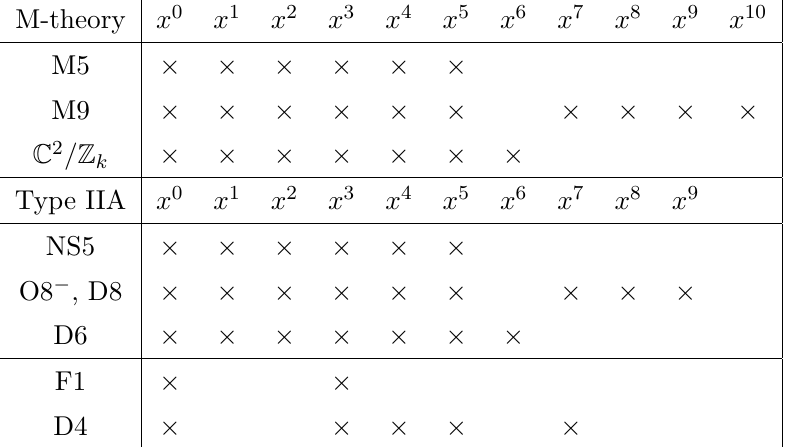
Table 1 . Upper part: occupation of space-time directions by M5, M9, and A k (cid:0) 1 singularity in M-theory. Lower part: occupation of space-time directions by NS5, O8 (cid:0) , D8, and D6 in Type IIA. The fundamental string F1 and the D4 branes are virtual objects which are used to read o(cid:11) the electric and magnetic